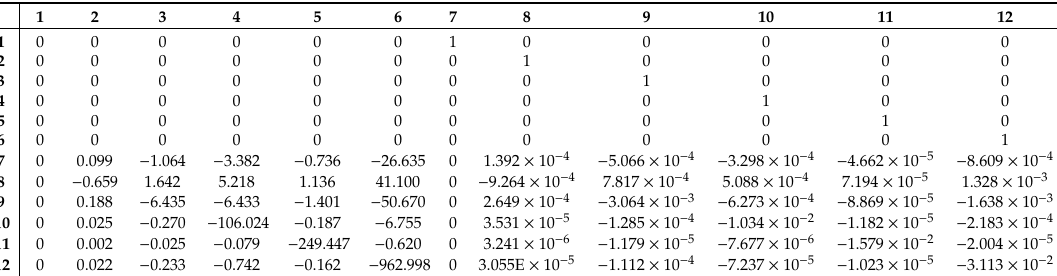
Table 6. State space [ A ] matrix 1